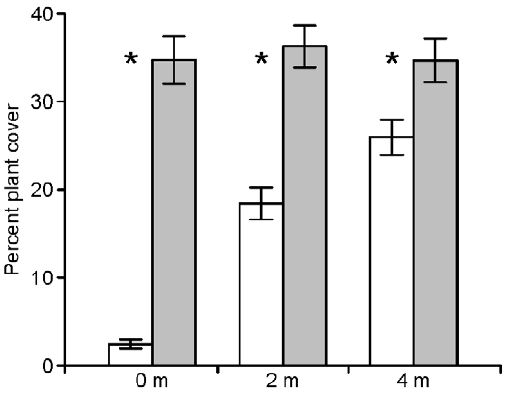
Figure 4. Patterns of vegetation cover at kangaroo rat mounds. Percent plant cover (mean 6 SE) in 1-m quadrats at occupied banner- tailed kangaroo rat mounds (white bars, n =30) and random sites . 20 m from a mound (shaded bars, n =30). Percent plant cover was measured at 0 m, 2 m, and 4 m from center of the mound or random site. Vegetation was surveyed twice during summer 2006 and averaged for each site. An asterisk denotes a statistically significant difference ( P , 0 . 05 in two-tailed t -test on arcsine square root transformed data) between mounds and random sites at that distance.